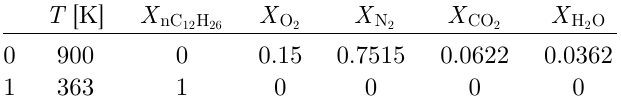
Table 1. Boundary conditions for the fl amelet model under the ECN Spray A baseline conditions ( Z = 0: = 0.045: stoichiometry). The oxidizer; Z = 1: fuel; Z = Z st pressure is p = 60